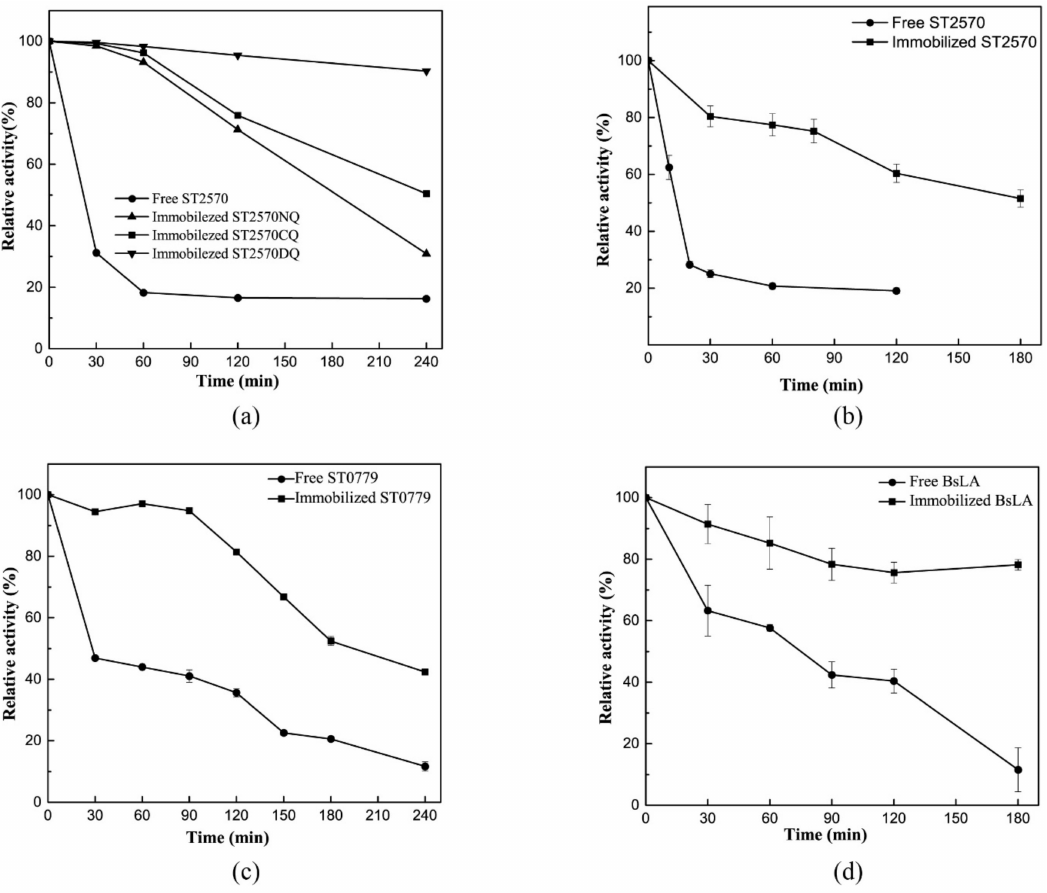
Figure 6. The thermostability of free and immobilized enzyme. ( a ) The thermostability of free and immobilized ST2570 by resin D380 at 90 ◦ C; ( b ) the thermostability of free and immobilized ST2570 by SBA-15 at 90 ◦ C [28]; ( c ) the thermostability of free and immobilized ST0779 by Fe 3 O 4 at 85 ◦ C; ( d ) the thermostability of free and immobilized BsLA by Fe 3 O 4 at 50 ◦ C